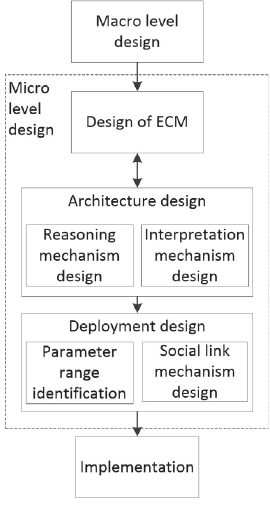
Fig. 2. Micro level design of affective